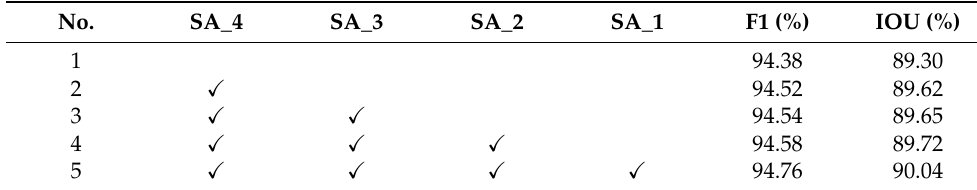
Table 5. Evaluation results of different levels of SA units on the WHU building dataset. Note: the